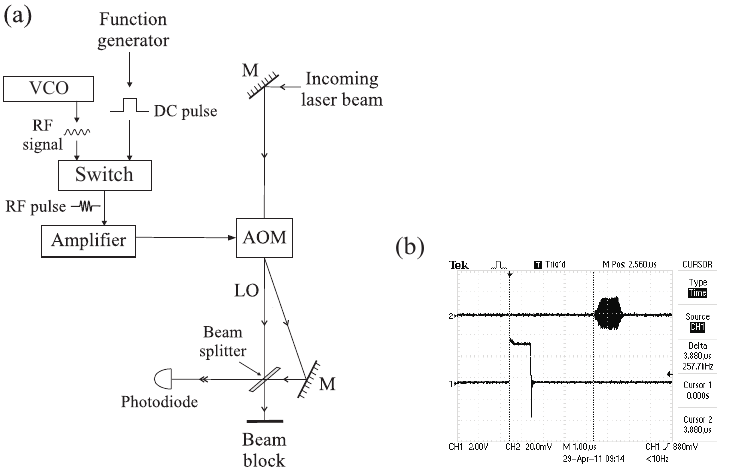
Figure 12. ( a ) Heterodyne detection setup. The incoming beam is generated by an ECDL operating at 780 nm. The optical local oscillator (LO) is the undiffracted beam from the acousto-optic modulator (AOM). Light from one of the ECDL-based experiments described previously is aligned through th. The first order diffracted beam from the AOM is rendered co-propagating with the LO using a beam splitter and mirrors so that a heterodyne beat signal can be detected by the photodiode. The RF input to the AOM is either CW or pulsed, and the control electronics are shown. The output of the TTL switch is an RF pulse that drives the AOM. ( b ) The square pulse used to amplitude-modulate the AOM and corresponding time-delayed optical pulse detected by the photodiode. The square pulse is the signal input to the electronic TTL switch, which also triggers the oscilloscope. The optical pulse exhibits a beat note at the AOM drive frequency. The time delay between the onset of the square pulse and the beginning of the optical pulse is 3.45 ± 0.05 µ s. This delay is consistent with the estimated time for an acoustic wave to propagate from the transducer at the edge of the AOM crystal to the location of the laser beam passing through the